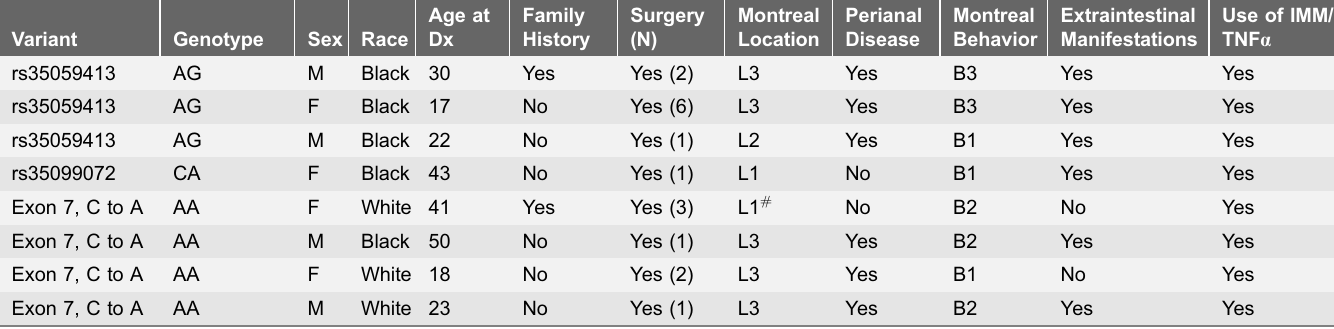
Table 4. Specific Phenotypic Data of Individual Patients with at Least 1 IDO1 Variant